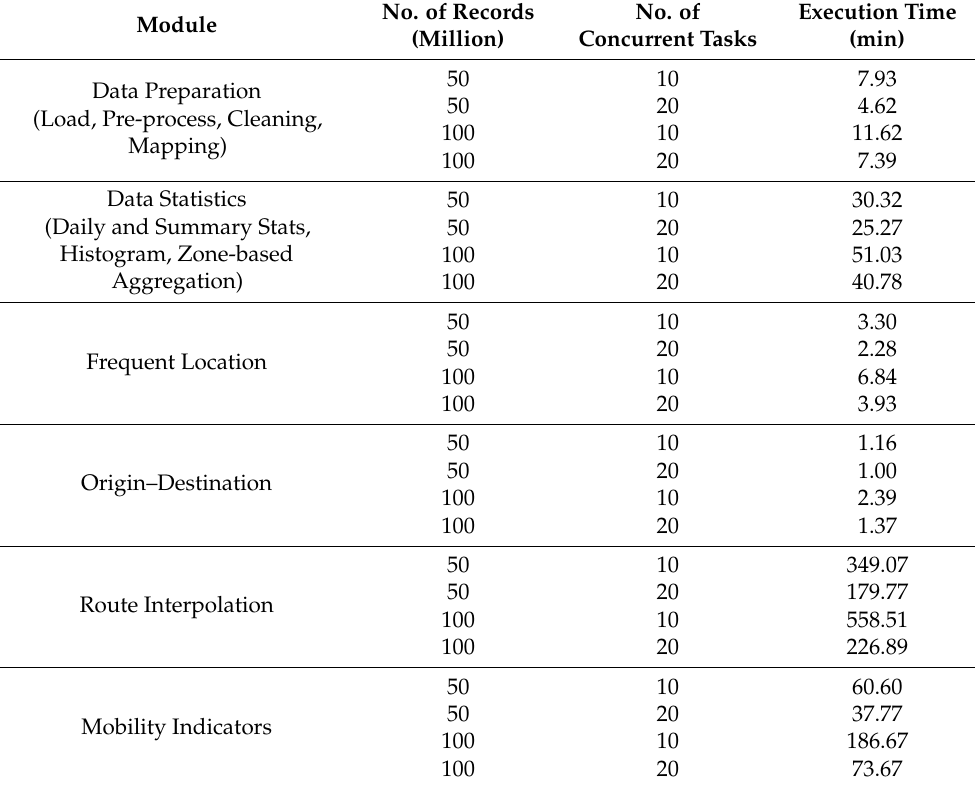
Table 7. Performance evaluation for the other Hadoop-/Hive-based